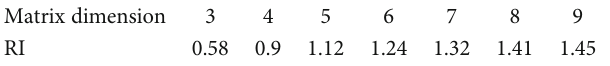
Table 2: Order of blasting parameter